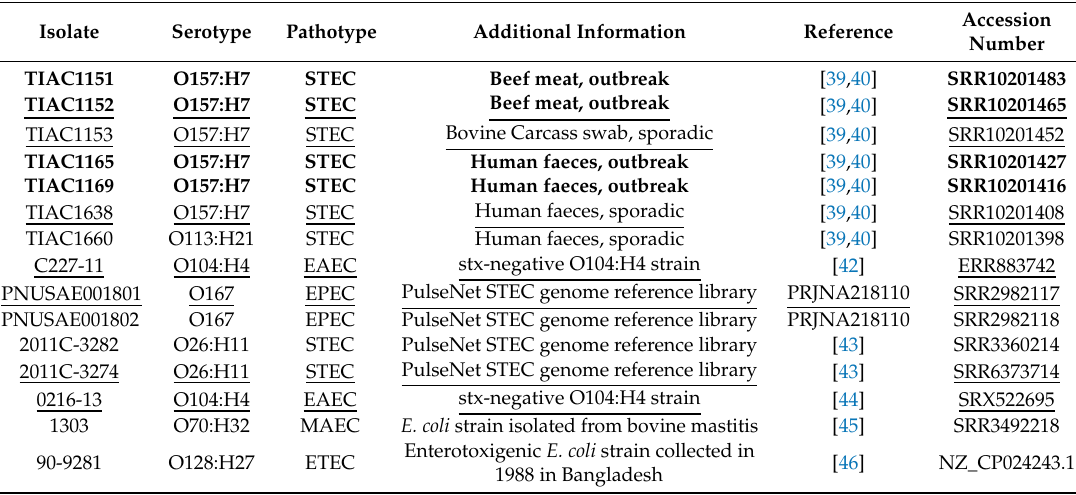
Table 1. Isolate sequencing